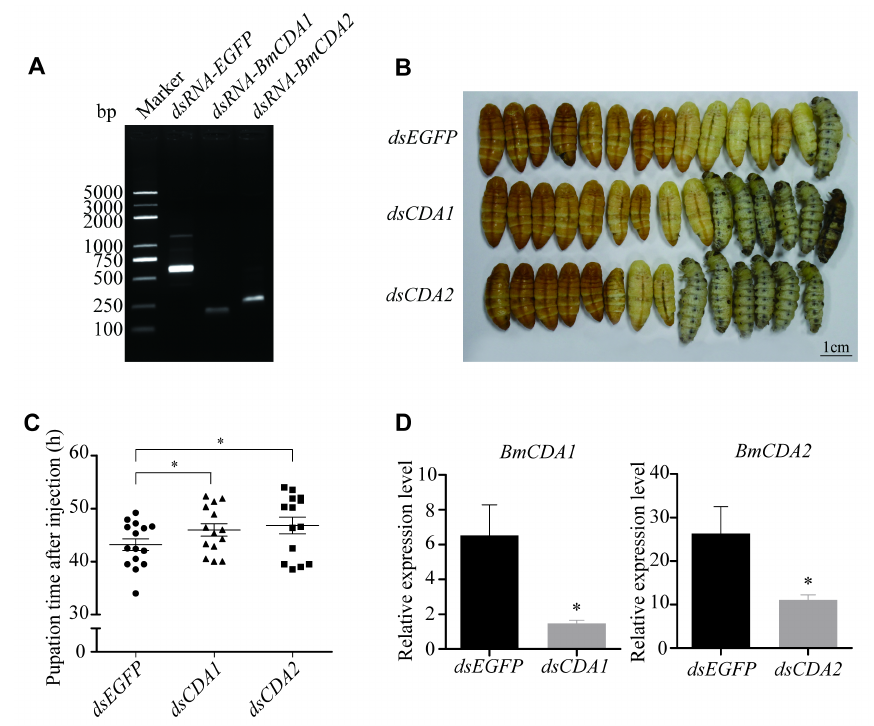
Figure 8. Interference of BmCDA1 and BmCDA2 in larvae at the wandering stage. ( A ) Detection of dsRNA from EGFP , BmCDA1 , and BmCDA2 . ( B ) Phenotypes of insects injected with dsRNA for BmCDA1 and BmCDA2 . ( C ) Statistics of pupation time after injection with RNAi. ( D ) Expression levels of BmCDA1 and BmCDA2 after RNAi. dsEGFP =